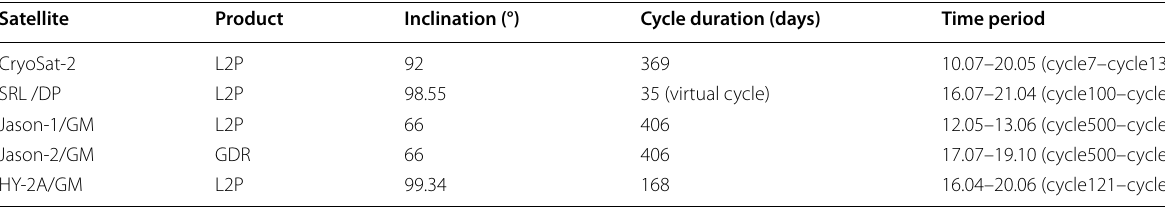
Table 2 Altimetry data information